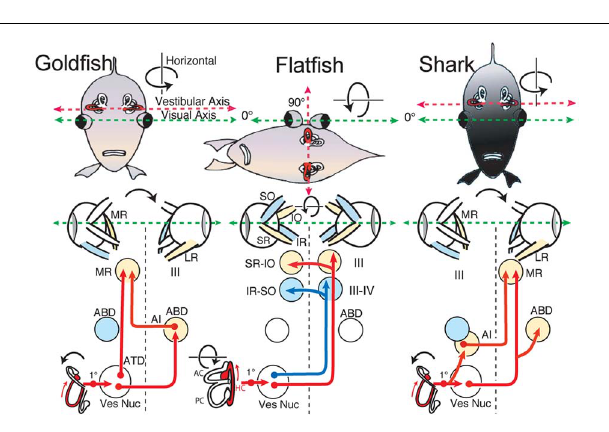
FIGURE 9 | Schematic diagram of horizontal vestibuloocular reflex circuitry in teleosts and elasmobranchs. “Goldfish” shows the principal three-neuronal vestibuloocular reflex linking the horizontal semicircular canal with contralateral abducens (ABD) and ipsilateral MR motoneurons. ”Flatfish” shows that after 90 ◦ displacement of the vestibular relative to visual axis (metamorphosis) compensatory eye movements are produced by redirecting horizontal canal signals to vertical and oblique (SR-IO and IR-SO) motoneurons. In “Shark,” horizontal canal/second order neurons project to contralateral ABD and MR motoneurons including ipsilateral AI neurons. 1 ◦ , first order vestibular neuron; ATD, AscendingTract of Deiter’s. Schematic diagrams based on results from Graf etal. (1997; goldfish), Graf and Baker (1985a,b; flatfish), and Graf etal. (2001; shark).